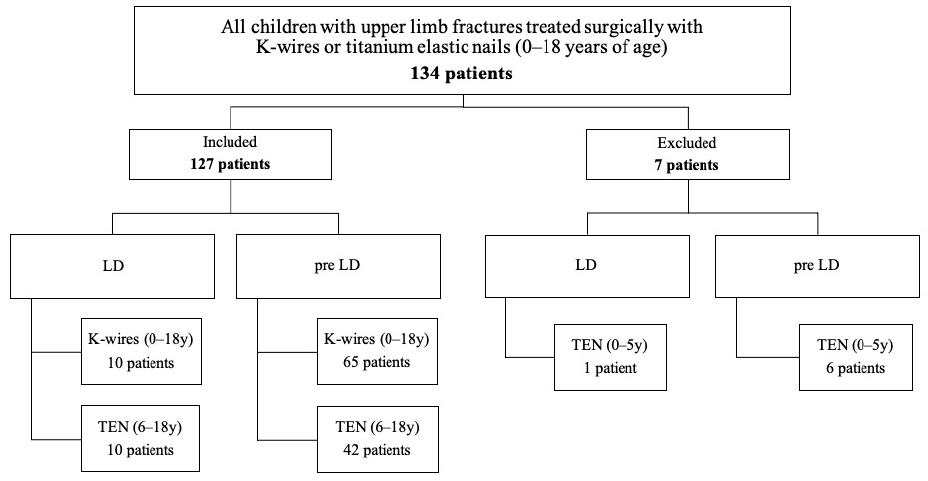
Figure 1. Flowchart of study population.